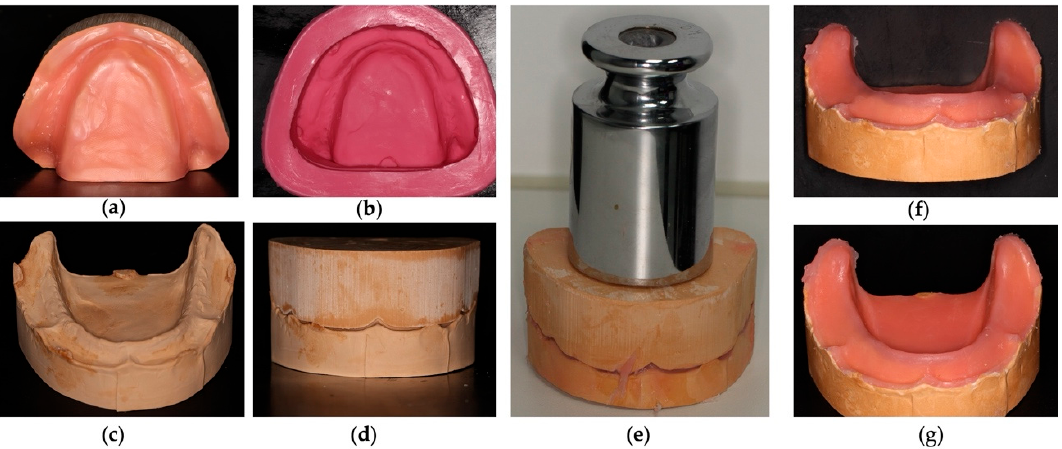
Figure 2. In vitro model simulating a total inferior edentulous. ( a ) Negative plaster model with wax application; ( b ) Duplication of the model with Dublisil ® 20; ( c ) Working model to perform mucosa simulation; ( d ) Positioning of positive and negative plaster models; ( e ) Models with characterization material awaiting adhesion with a weight of 1 Kg; ( f , g ) Final model of mucosa simulation.